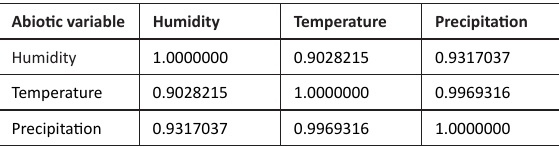
Table 2. Correlation of climatic factors. genus was found only in the first collection of the rainy season, being represented only by two males, this may indicate the preference of the species of this genus for open vegetation environments, but more extensive research is neede to prove this